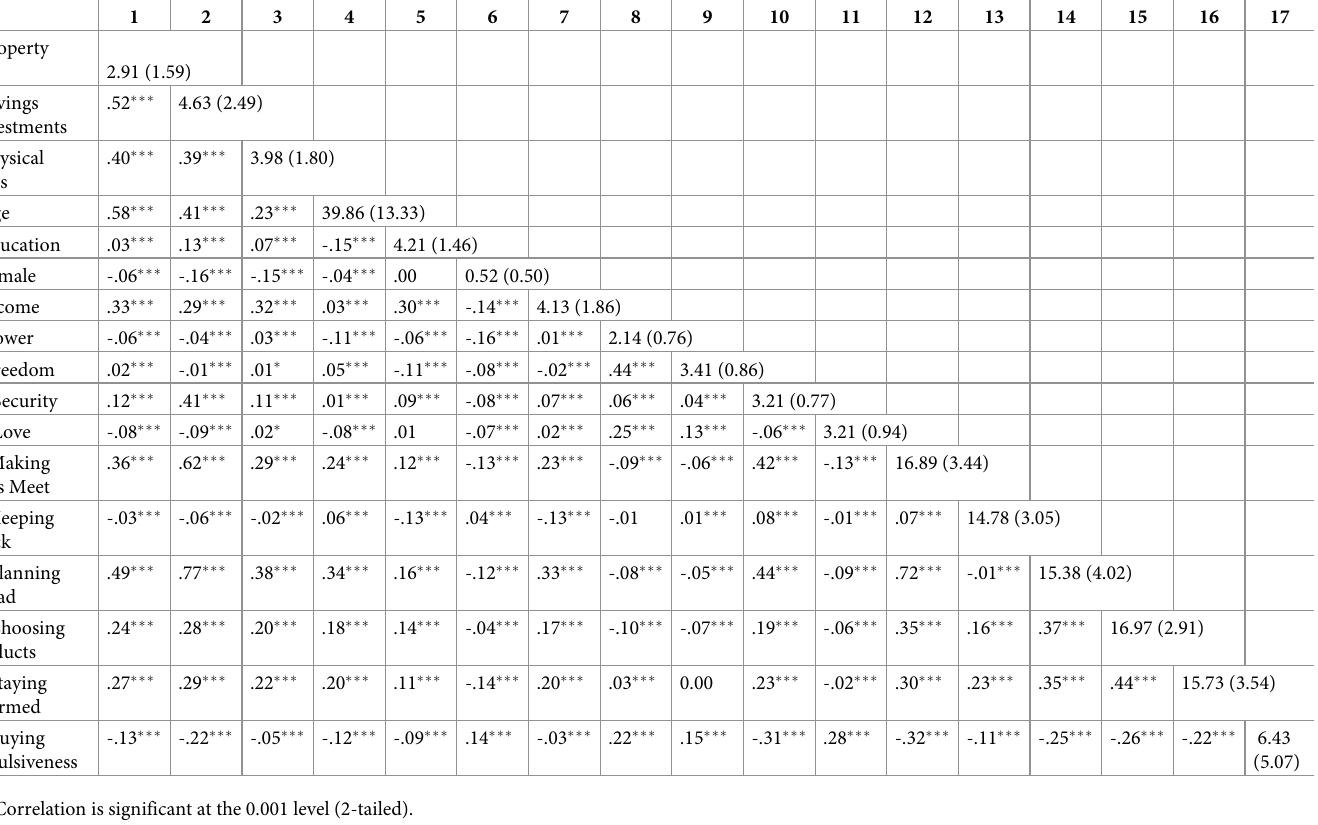
Table 1. Pearson correlations means and standard deviations of all